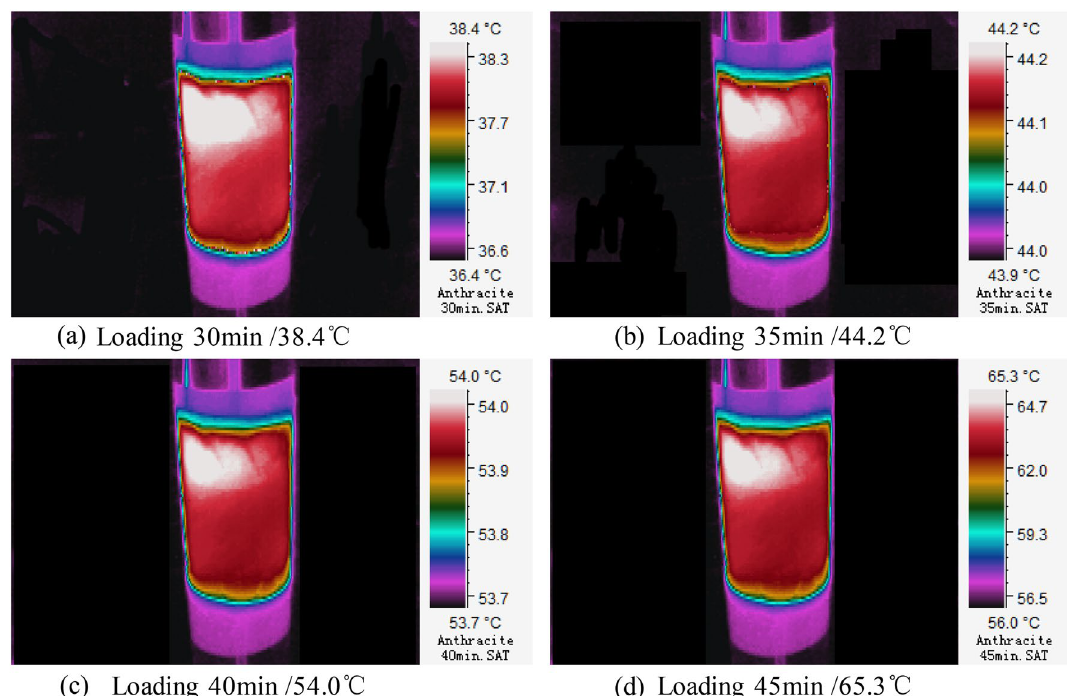
Figure 6. Three-dimensional infrared cloud maps of rapid warming